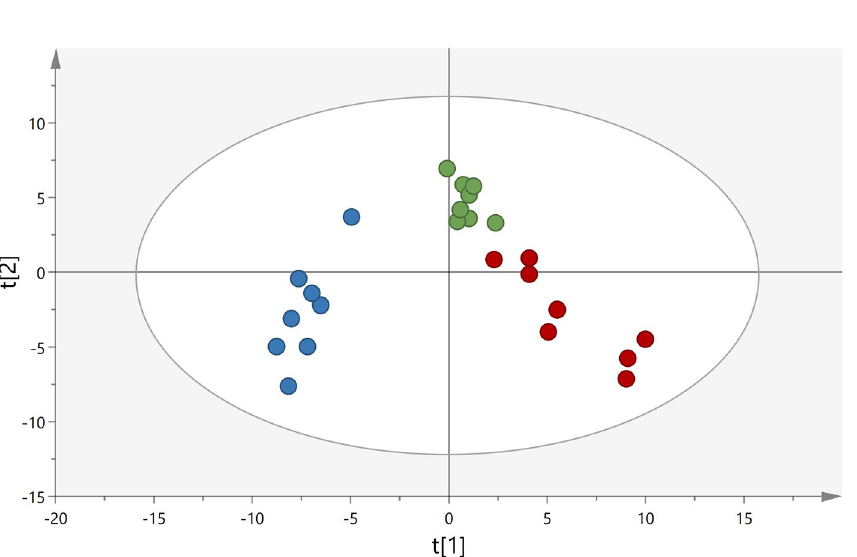
Figure 3. Principal component analysis (PCA) of the proteome over time. The score plot shows the dynamic changes of protein expression in all compartments; intracutaneous (green), subcutaneous (blue) and intravenous (red). The x-axis represents intergroup differences while the y-axis represents intragroup